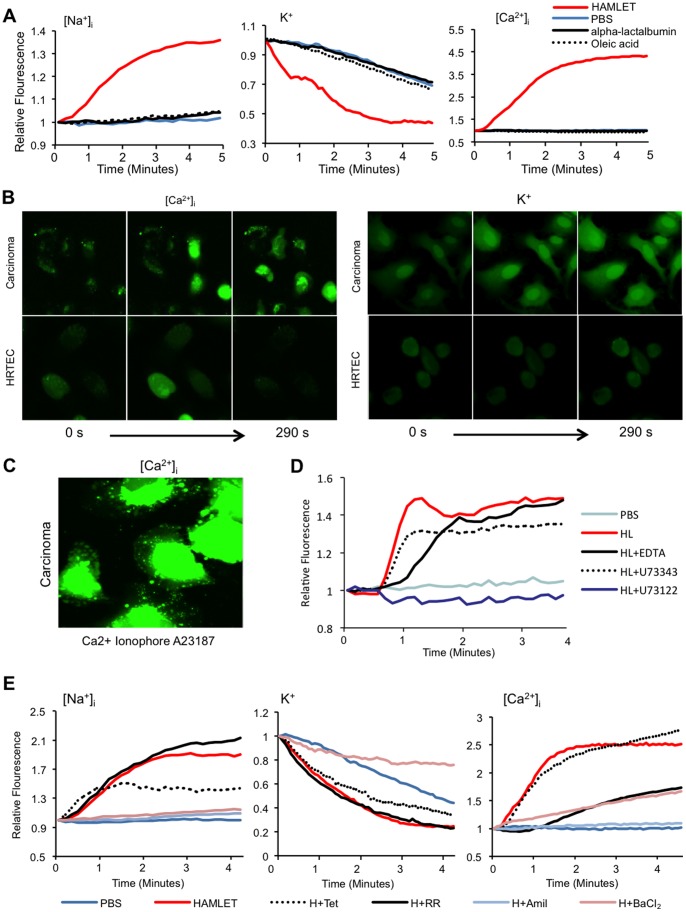
HAMLET alters intracellular ion concentrations in tumor cells.(A) Estimates of the relative free, intracellular concentrations of Na+, K+, and Ca2+ ([Na+]i, [K+]i, and [Ca2+]I, respectively) were obtained in A549 cells (K+ and Ca2+) and Jurkat cells (Na+) by fluorescence spectrometry using CoroNa Green, FluxOR and Fluo-4. Rapid ion fluxes were detected and these effects were HAMLET specific, as α-lactalbumin, oleic acid or PBS had no effect. (Means of four experiments, p<0.05 (Students t-test at t = 2 minutes) (B) Difference in HAMLET-induced ion fluxes between tumor cells and healthy cells. Ca2+ and K+ fluxes are visualized by real time confocal imaging of A549 lung carcinoma cells and HRTEC healthy, differentiated kidney cells, loaded with the Ca2+ and K+ fluorophores and treated with HAMLET (35 µM) for up to 290 seconds. Representative figures from three experiments are shown. (C) Calcium ionophore (A23187, 1 µM) response in A549 lung carcinoma cells loaded with Fluo-4. Representative figure from three experiments. (D) Inhibition of intracellular calcium release from ER reduces Ca2+ fluxes. A549 cells were pretreated with a PLC-inhibitor (10 µM, U73122), its inactive analogue (10 µM, U73343) or EDTA (1 mM) for 30 minutes and treated with HAMLET as indicated. Means of three experiments. (E) Amiloride (Amil, 1 mM) inhibited Na+ and Ca2+ fluxes in A549 cells (Ca2+) and Jurkat cells (Na+) induced by HAMLET (marked as H in figure). BaCl2 (1 mM) inhibited the Na+, K+ and Ca2+ fluxes. Cells were pre-loaded with the respective fluorophores, pretreated with inhibitors (30 minutes) and challenged with HAMLET (35 µM) for up to 5 minutes. Effects of amiloride on K+ fluxes could not be determined due to auto fluorescence. Ruthenium red (RR, 30 µM) reduced Ca2+ fluxes while tetranidrine (Tet, 10 µM) had no significant effect.